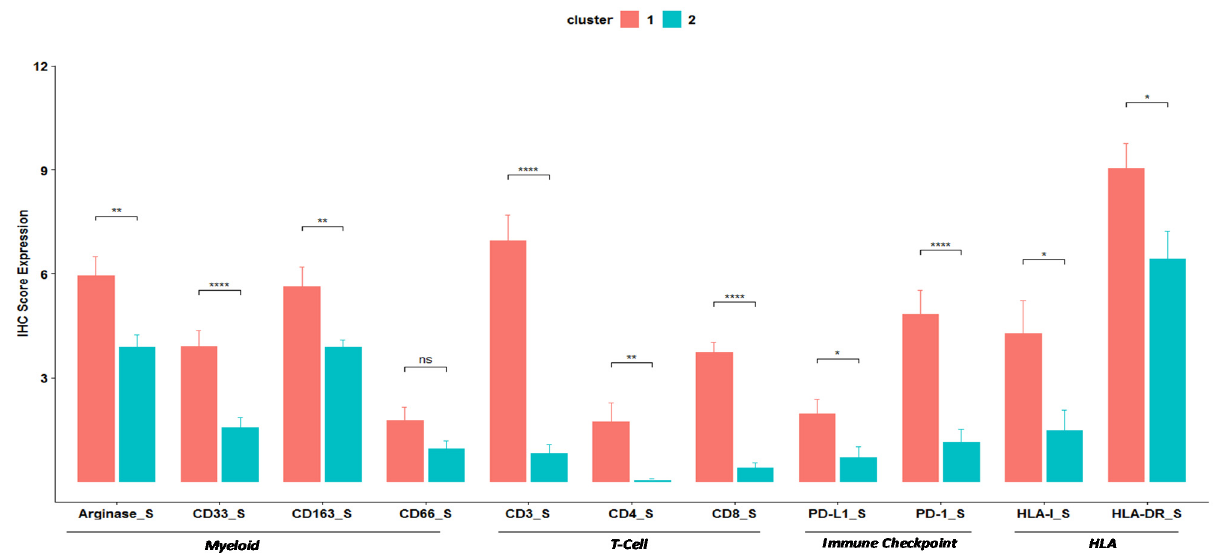
Figure 3. Barplots of immunohistochemistry Score Expression of Myeloid, T-cells, Immune checkpoint and HLA markers. * indicates the level of significance.